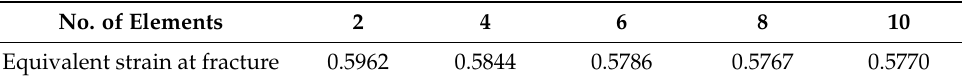
Table 2. Variations in the equivalent strain at the fracture as number of elements in the thickness direction of the strip changes.